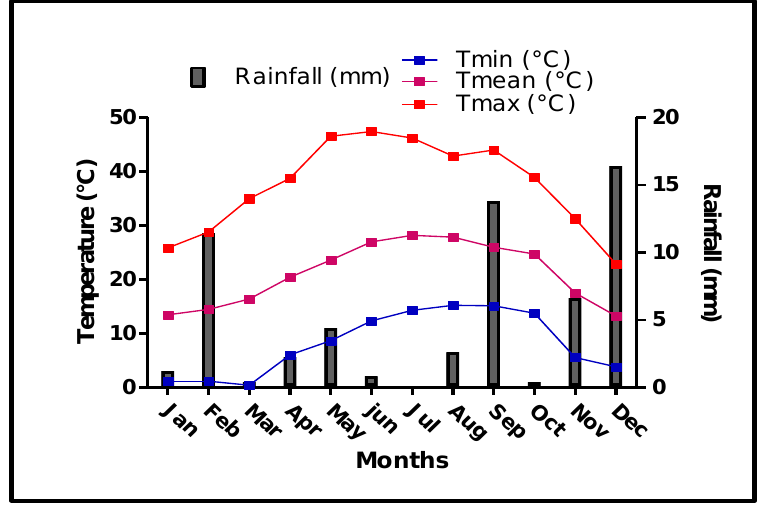
Figure 1. Monthly minimal, maximal and mean air temperature (Tmin, Tmax and Tmean, respec- tively) and rainfall during 2016.